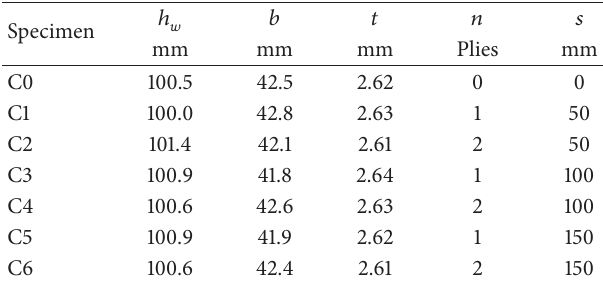
Table 1: Parameters of